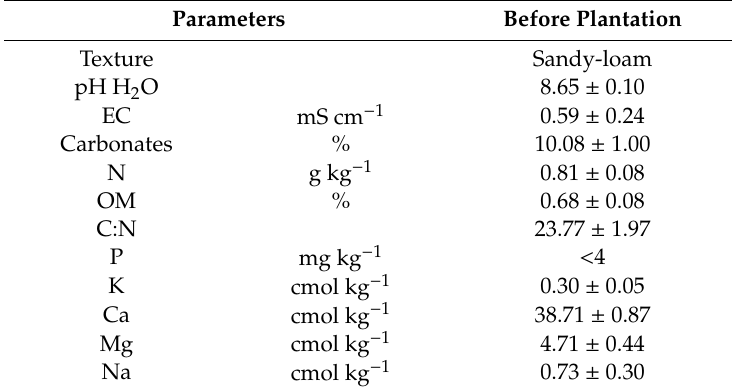
Table 1. Average values ± standard deviation of physical-chemical parameters and concentrations of assimilable Phosphorus and interchangeable elements (Potassium, Calcium, Magnesium and Sodium) on the surface horizon of the soil (0–30